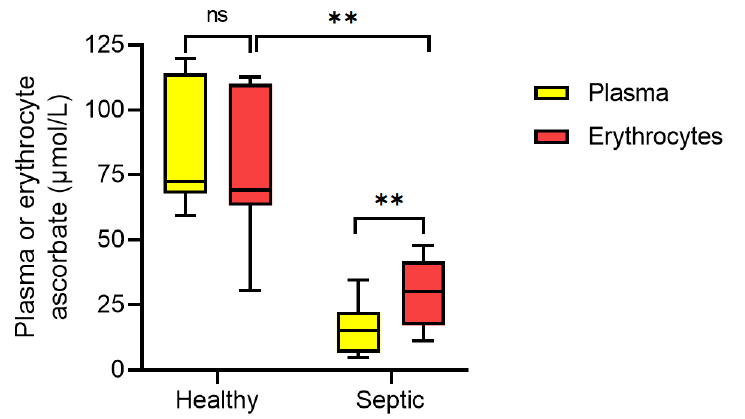
Figure 2. Erythrocyte ascorbate content relative to plasma concentrations. The ascorbate status of plasma (yellow bars) and erythrocytes (red bars) from healthy volunteers ( n = 7) and septic patients ( n = 9) was determined by HPLC. Box plots show medians with 25th and 75th percentiles as boundaries and whiskers indicate the range. ** p = 0.002 for healthy vs. septic erythrocyte ascorbate concentrations (Mann–Whitney U test) and p = 0.008 for paired septic plasma and erythrocyte ascorbate concentrations (Wilcoxon paired signed-rank